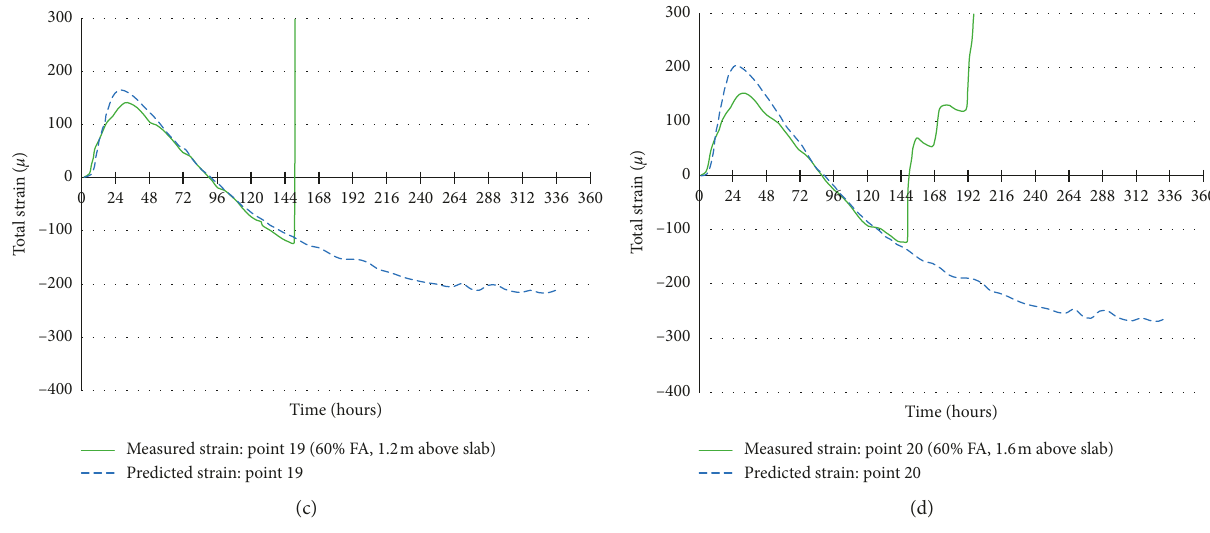
Figure 13: Simulated and measured total strain developments in the 5.0 m section of the low-heat concrete.